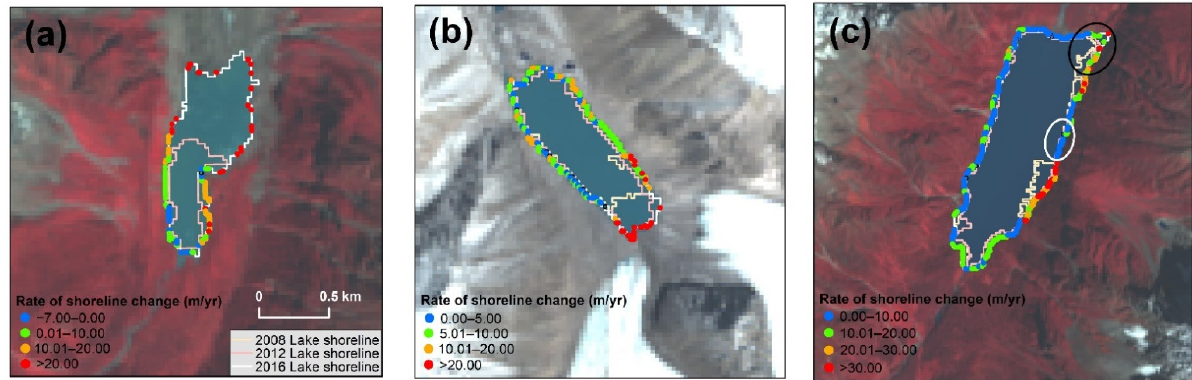
Figure 8. Examples of shoreline erosion and expansion rates measured at 30 m intervals between 2008, 2012, and 2016 for lake ( a ) (94.2667 ◦ E, 30.1018 ◦ N); lake ( b ) (89.1916 ◦ E, 28.3325 ◦ N); and lake ( c ) (94.0917 ◦ E, 30.1251 ◦ N).